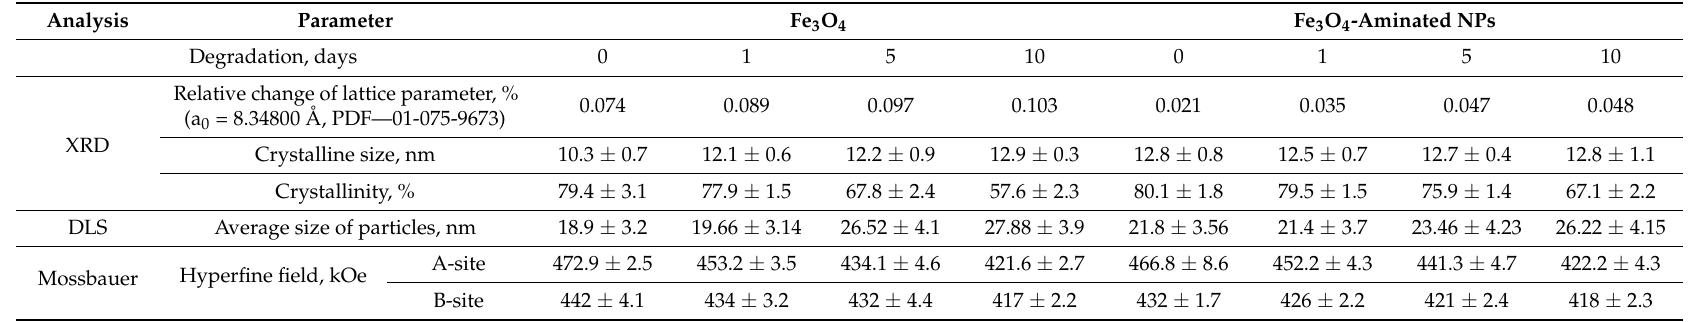
Table 2. Changes in the structure of magnetic nanoparticles and after modification with APTMS occurring during degradation in PBS solution.